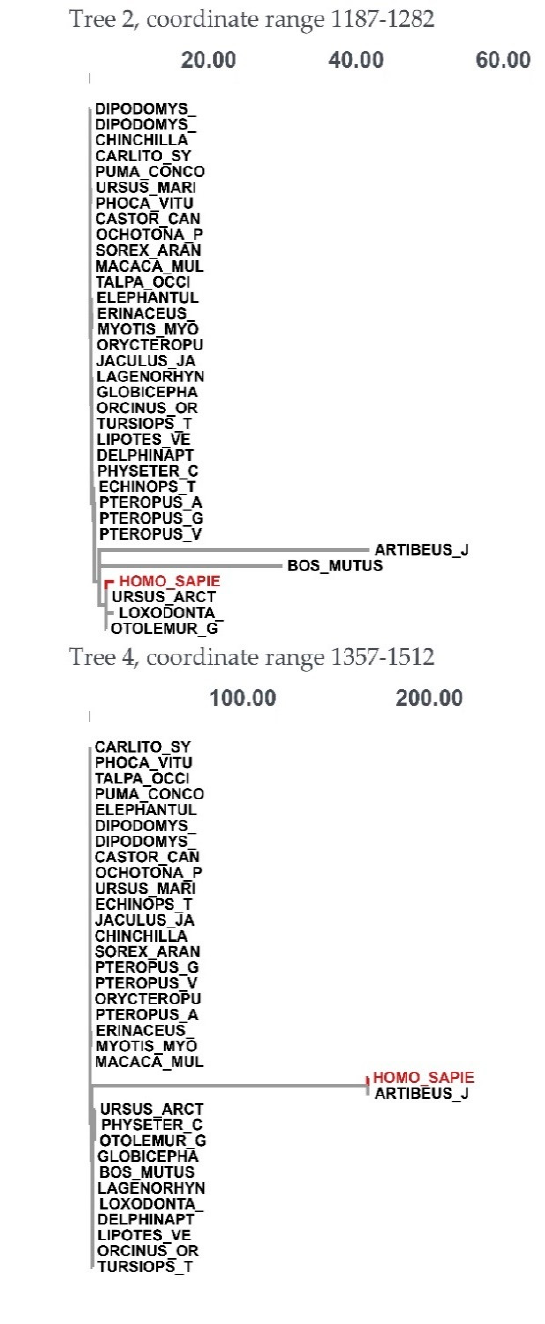
Figure 4. Trees for individual fragments showing recombination breakpoints in the BPIFA1 gene among mammalian species.